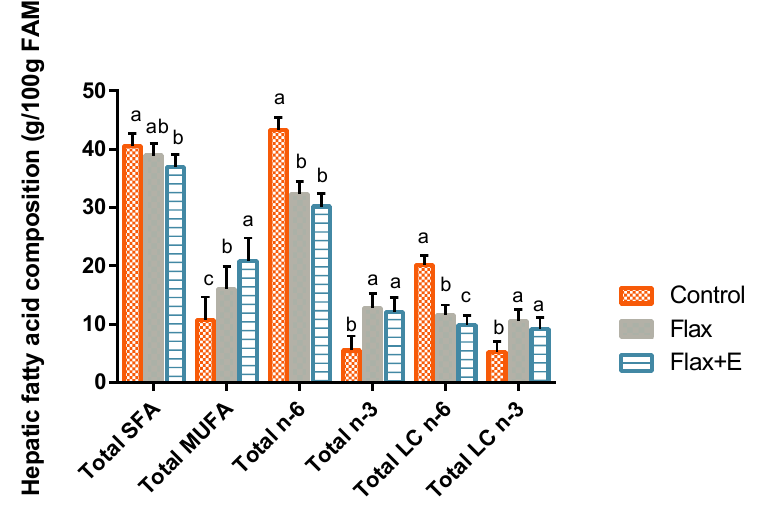
Figure 1. Effect of flaxseed and enzyme supplementation on liver fatty acids. Control, Flax, Flax+E represent corn-soybean meal basal diet (control), and basal diet with 10% whole flaxseed (Flax) plus 0.05% enzyme (Flax+E). The a–c means, with no common superscript within a cluster, differ when p < 0.05. n = 8. Data is represented as g per 100 g fatty acid methyl esters (FAME). SFA = saturated fatty acids. MUFA = monounsaturated fatty acids. LC = Long chain (>20C).